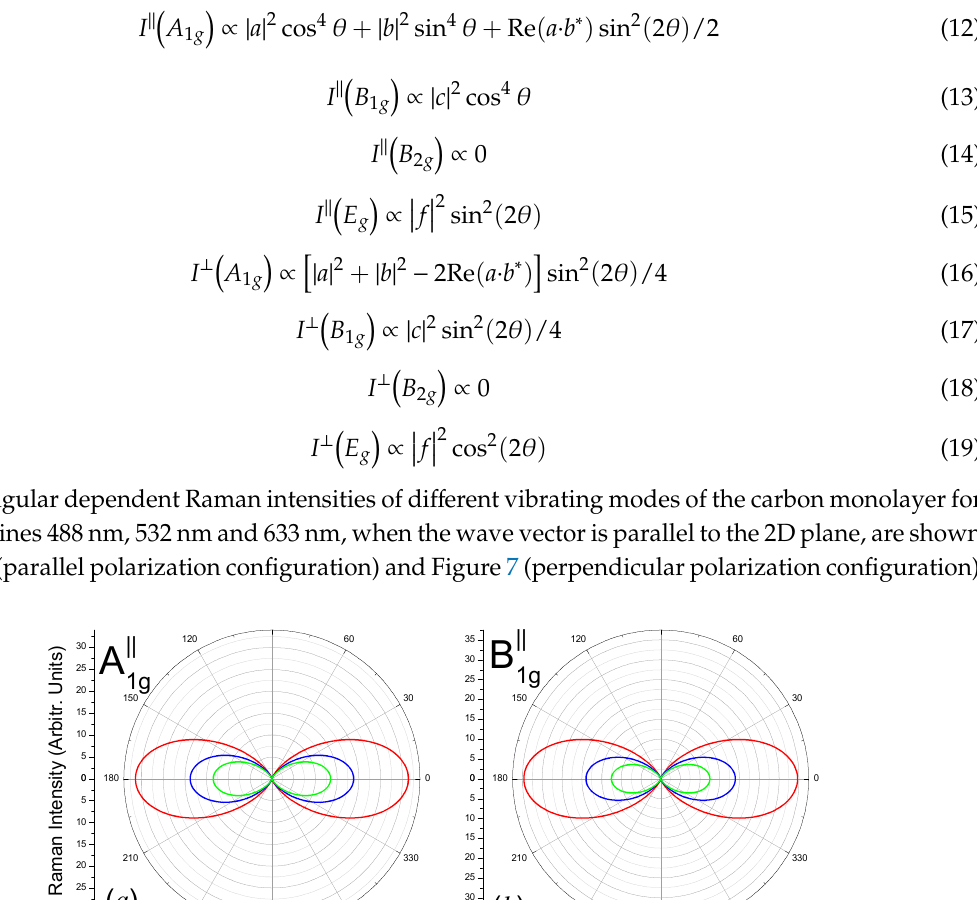
Figure 6. Polar plots of the angular dependent Raman intensities (cid:3627)𝑒⃑ (cid:3046) ∙ 𝑅⃡∙ 𝑒⃑ (cid:3036) (cid:3627) cm − 1 , ( b ) B 1g ‐ 1112 cm − 1 and ( c ) E g ‐ 574 cm − 1 modes of the octagon ‐ structure carbon monolayer excited by laser lines 488 nm (green), 532 nm (blue) and 633 nm (red). The polarization direction of the scattered light is parallel to the polarization direction of the incident light. The incident and scattered light wave vectors are in the x ‐ direction.